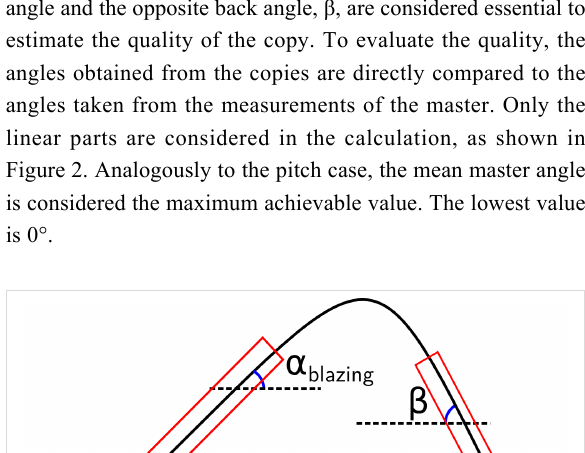
Figure 1: Two-step fabrication of samples. The left column shows three pictures taken at different angles of a negative PDMS mold created from the master. The remaining columns show three replicas (one per row) at different angles obtained by nanoimprint from the PDMS mold.